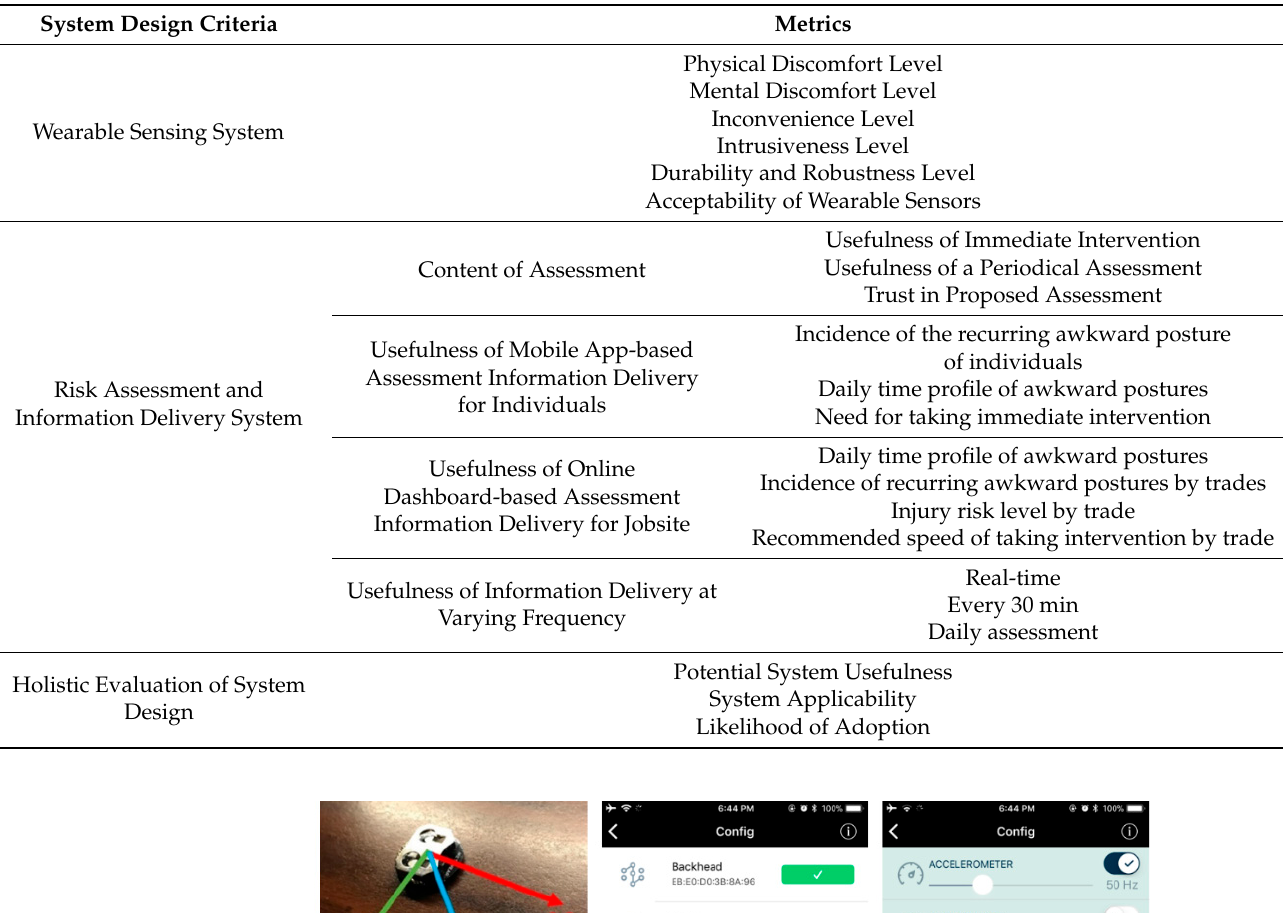
Table 2. System criteria and metrics for evaluation.